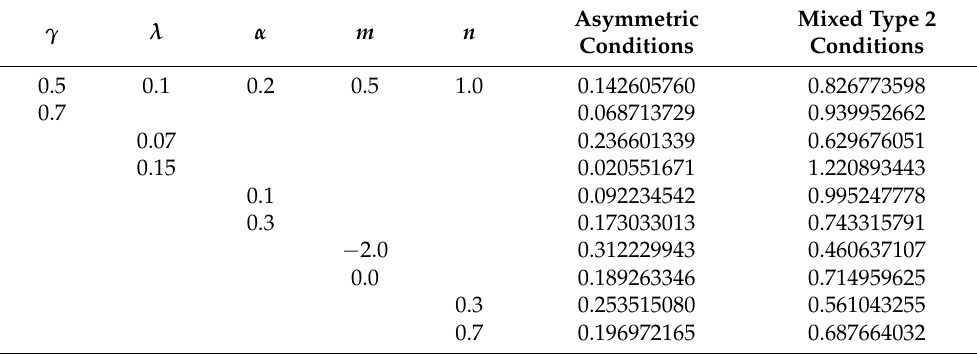
Table 1. The concentric cylinder wall heat gradient for different conditions.